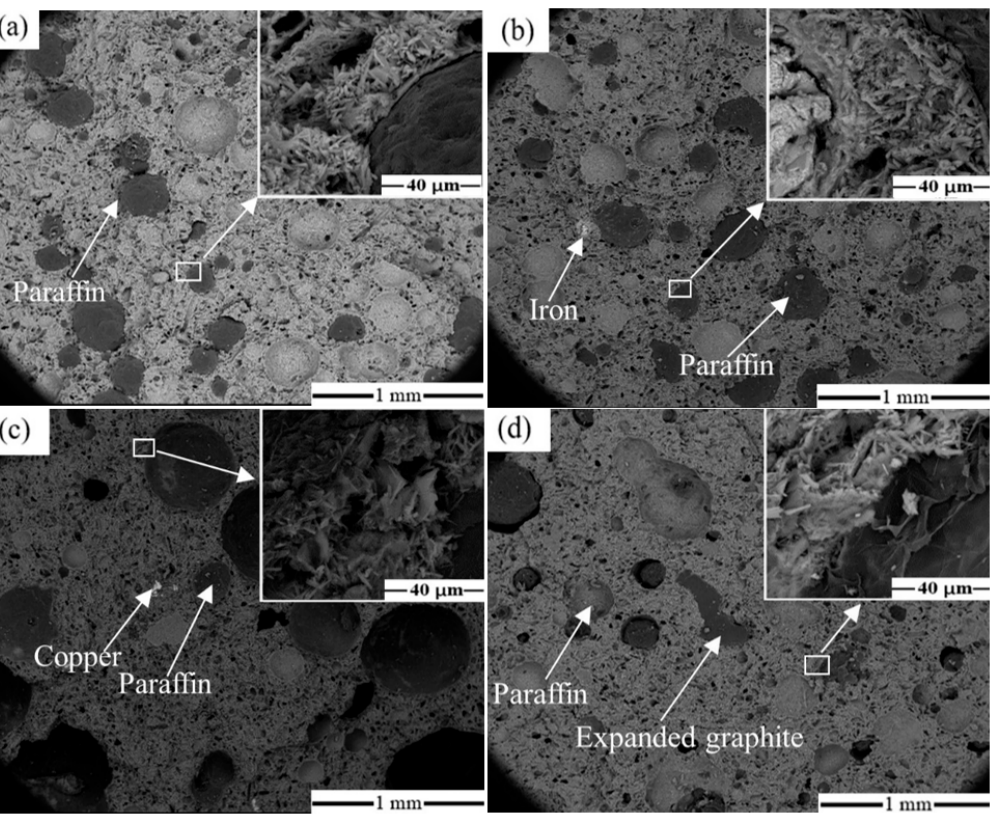
Figure 5. SEM images of the PA/gypsum and TC/PA/gypsum composites. ( a ) PA/gypsum composites; ( b ) PA/gypsum composite with 8 wt.% iron powder; ( c ) PA/gypsum composite with 8 wt.% copper powder; ( d ) PA/gypsum composite with 8 wt.% EG.